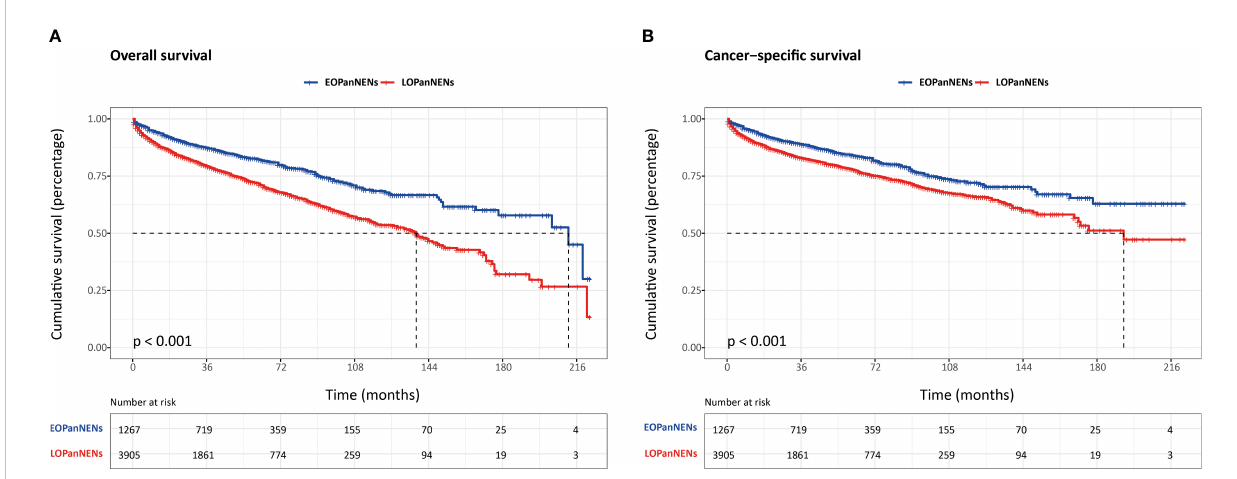
FIGURE 6 The overall survival (A) and cancer-speci fi c survival (B) between EOPanNENs and